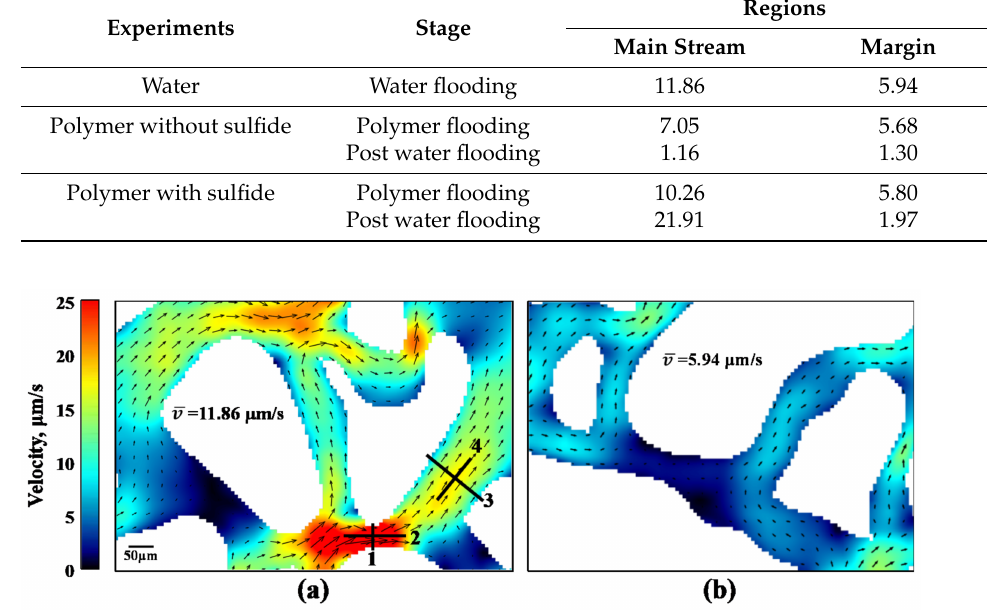
Figure 5. Velocity fields during water flooding at the main stream ( a ) and margin ( b